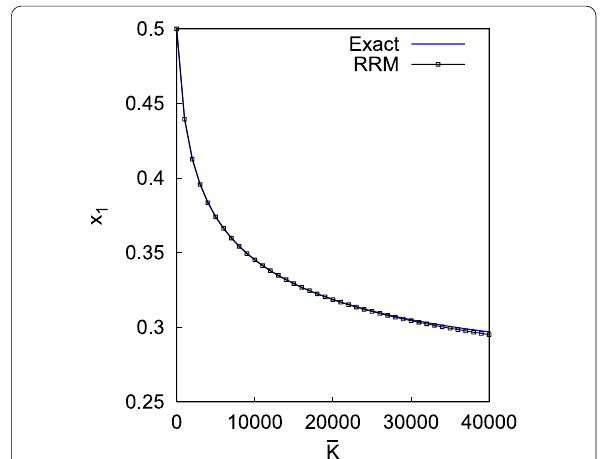
Fig. 8 Case (2) Variation of lift-off point, x 1 , for different values of K